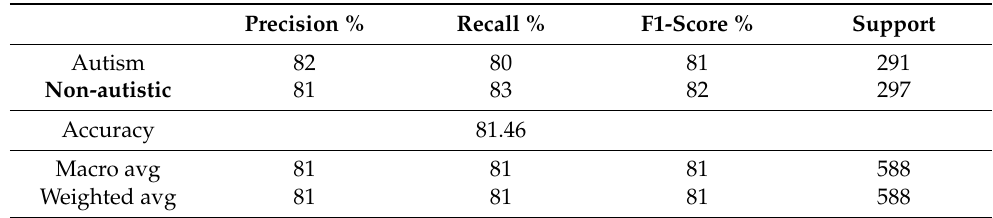
Table 4. Results of VGG-16 with linear SVC.